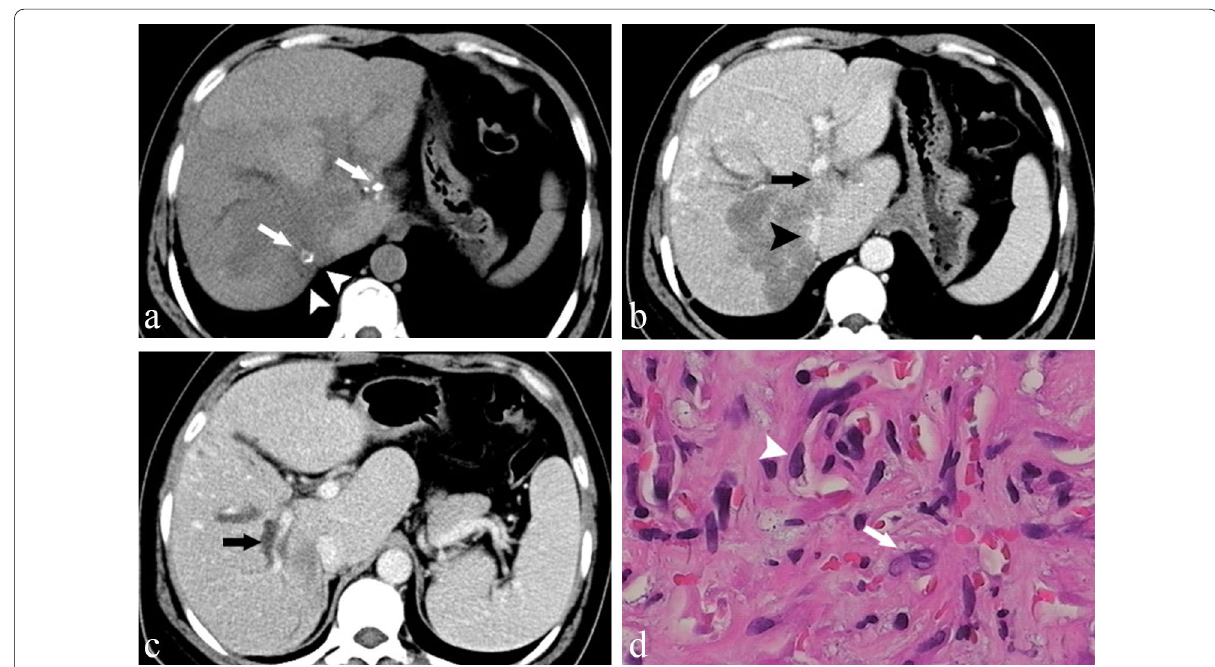
Fig. 2 A 40-year-old female pathologically confirmed HEHE before the CT examination. a Axial unenhanced CT illustrates nodules coalesced into a mass with ill-defined borders; hepatic capsular retraction ( arrowheads ) and calcification inside the tumour ( arrows ). Axial portal venous phase contrast-enhanced CT demonstrates left portal vein invasion ( arrow, b ), inferior vena cava invasion ( arrowhead, b ) and right portal vein invasion ( arrow, c ). d The histopathological section shows some dendritic ( arrowhead ) and endothelial cells (arrows) making primitive vascular structures with red blood cells